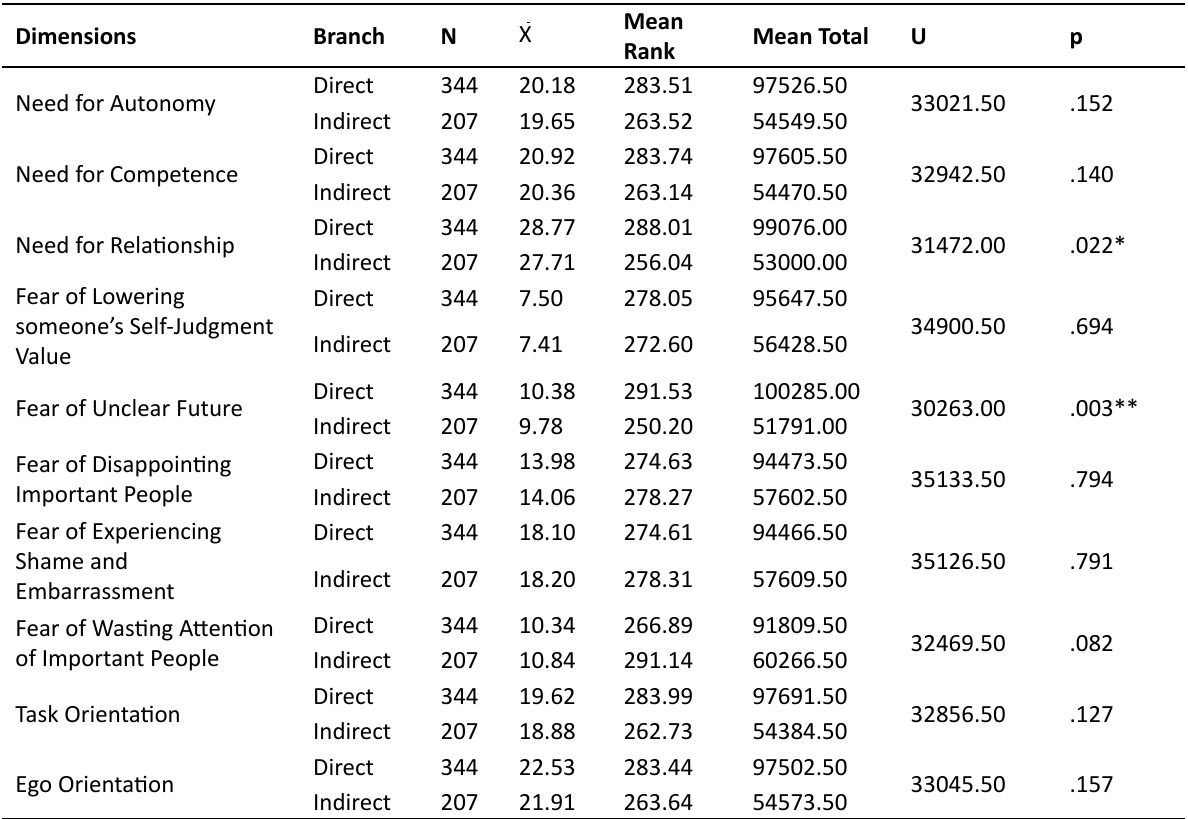
Table 3. Evaluation of the grades of the participants’ basic psychological needs, performance failure appraisal and task and ego orientation in sport according to branch variable